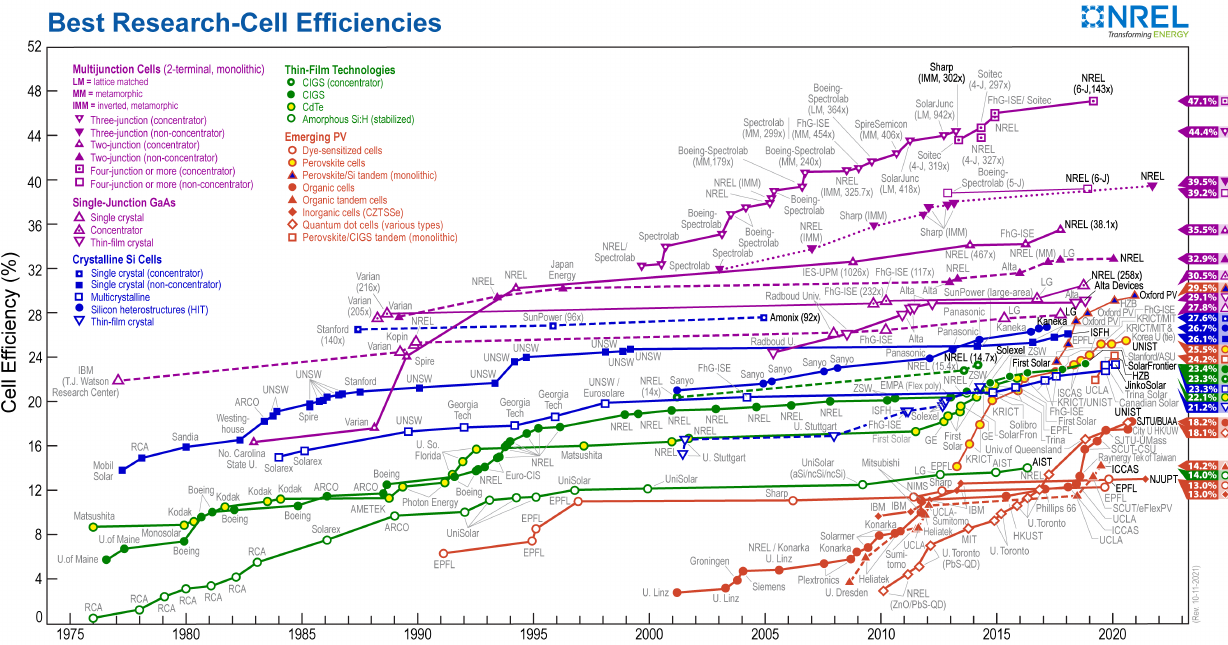
Figure 7. Evolution of Research-Cell Efficiency from a mere 5% to as high as 47% a [34]. a This plot is courtesy of the National Renewable Energy Laboratory, Golden,